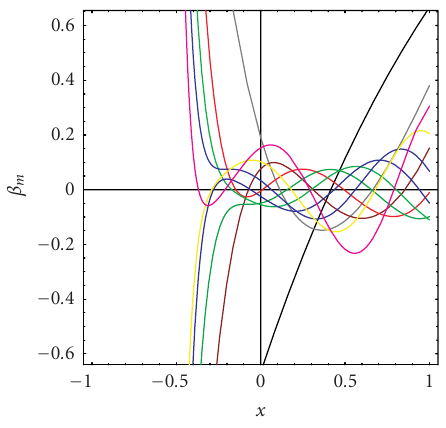
Figure 3.1. The curve of β m ( x ,1 | 1 / 2), 1 ≤ m ≤ 10, − 1 ≤ x ≤ 1